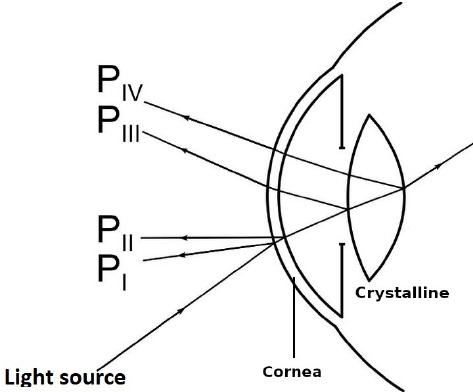
Figure 1. Purkinje images generated on the optical surfaces of the eye.